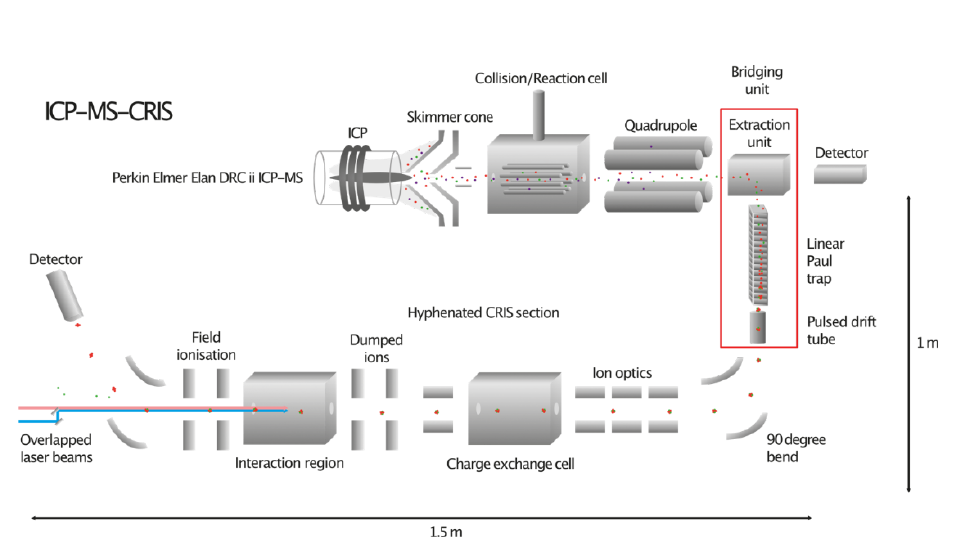
Fig. 2. Manchester CRIS setup with hyphenation to ICP-MS instrumentation for